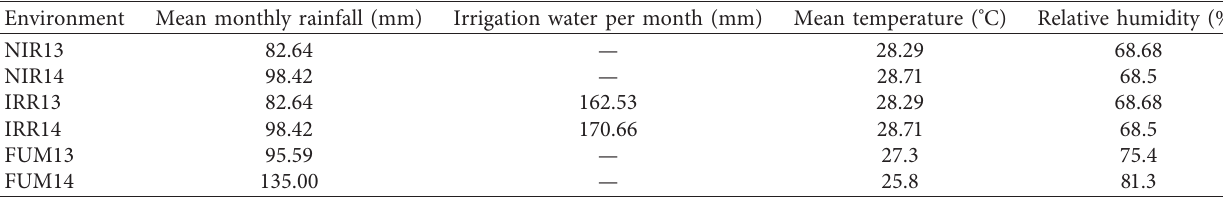
Table 2: Average monthly rainfall, irrigation water supplied, temperature, and relative humidity.